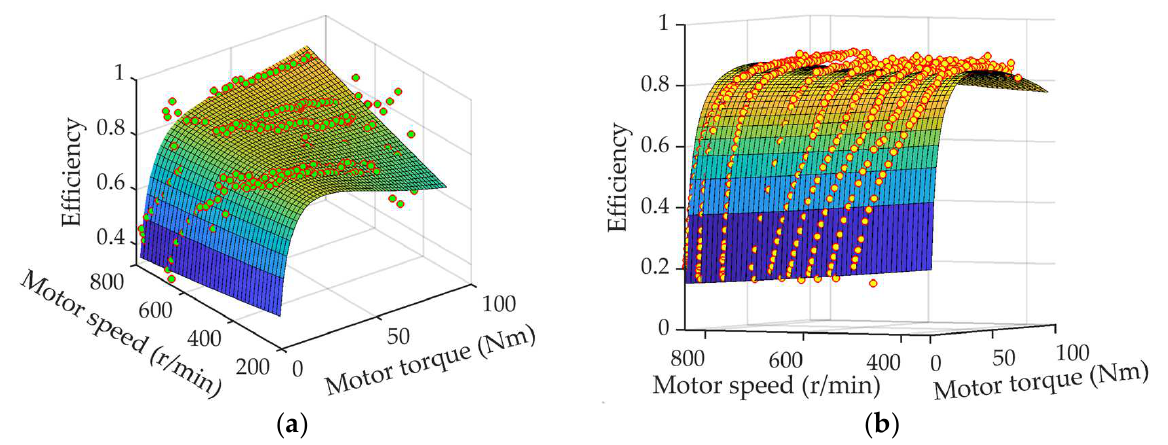
( b ) Figure 13. Iterative evolution curves of parameter identification of two motor efficiency models. ( a ) 8 kW motor; ( b ) 5 kW motor. Figure 13 shows that the I-SA algorithm has a good application result for the param-